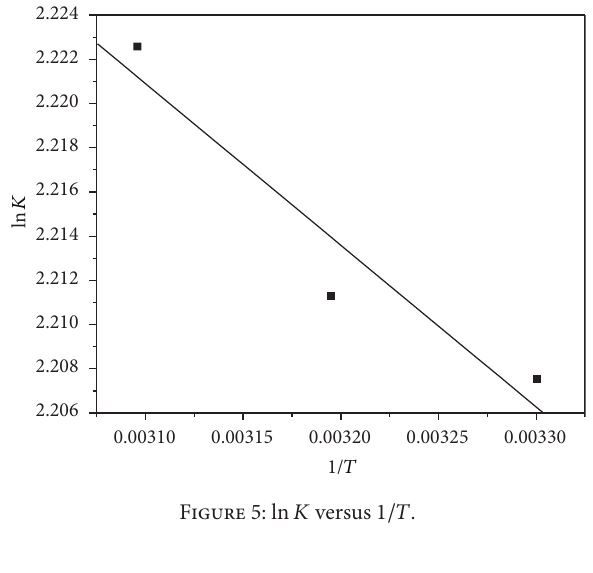
Figure 5: ln 𝐾 versus 1/𝑇